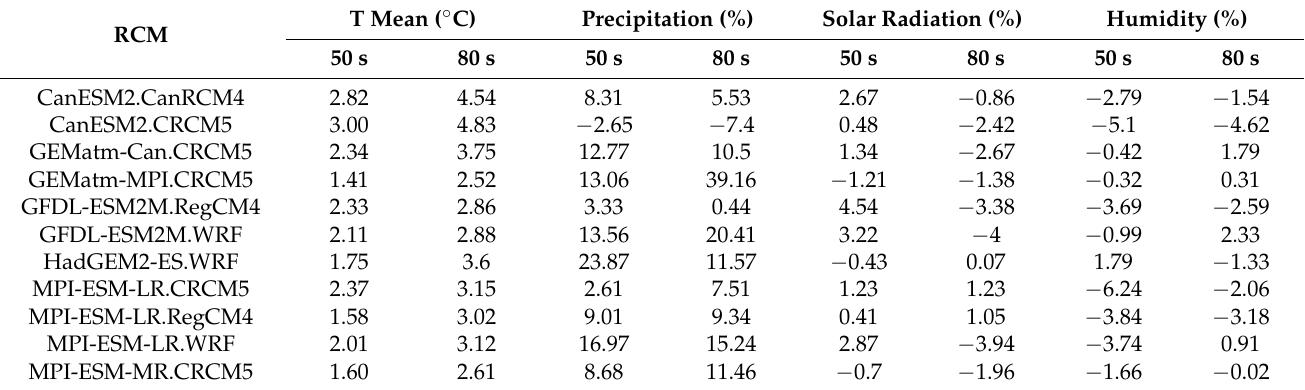
Table 5. Annual changes relative to baseline period in weather parameters under